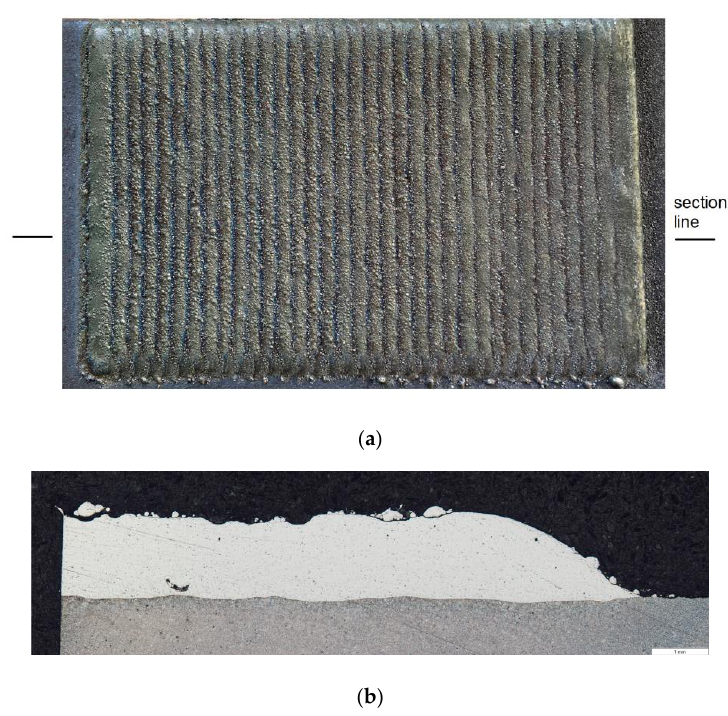
Figure 20. Ni-20Cr+Re multi-bead deposit sample produced at the laser power of 2400 W: ( a ) a photo of the clad surface (100 × 50 mm 2 substrate size), ( b ) microstructure of the multi-bead clad prepared for the section area at a distance of about 20 from the start of the